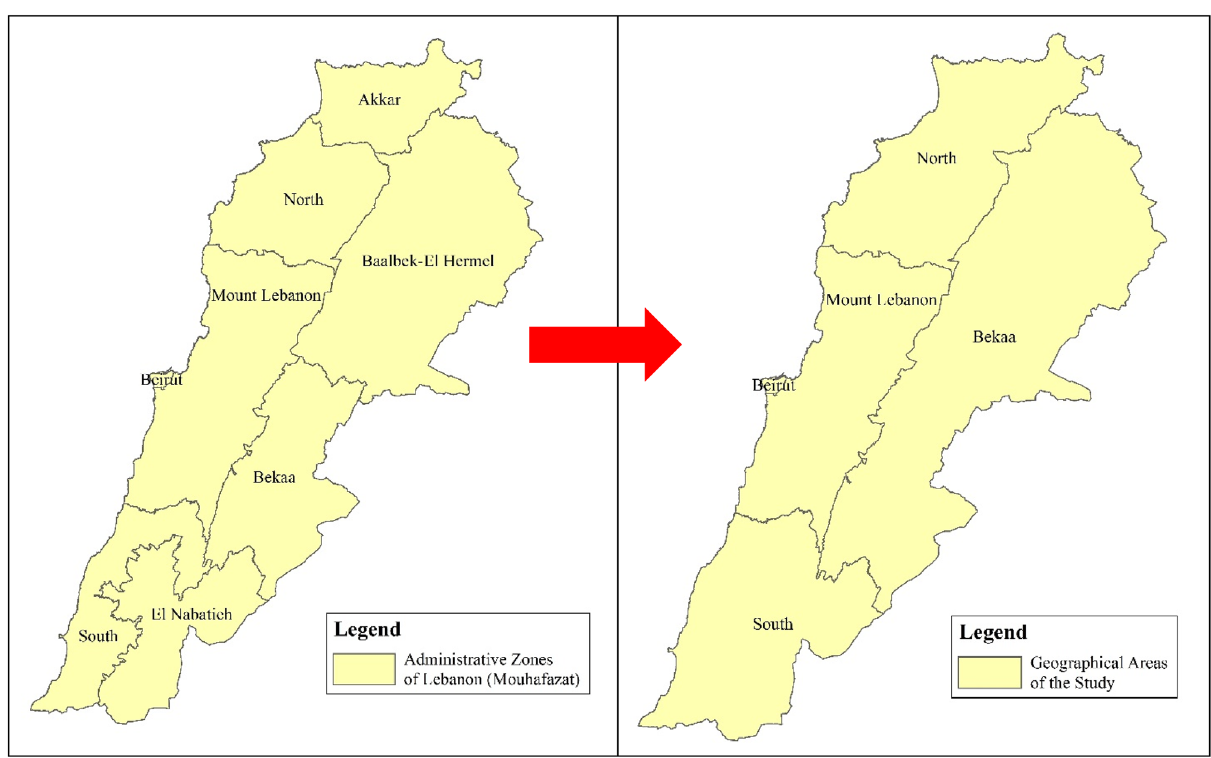
Fig. 9 Administrative zones and selected study areas